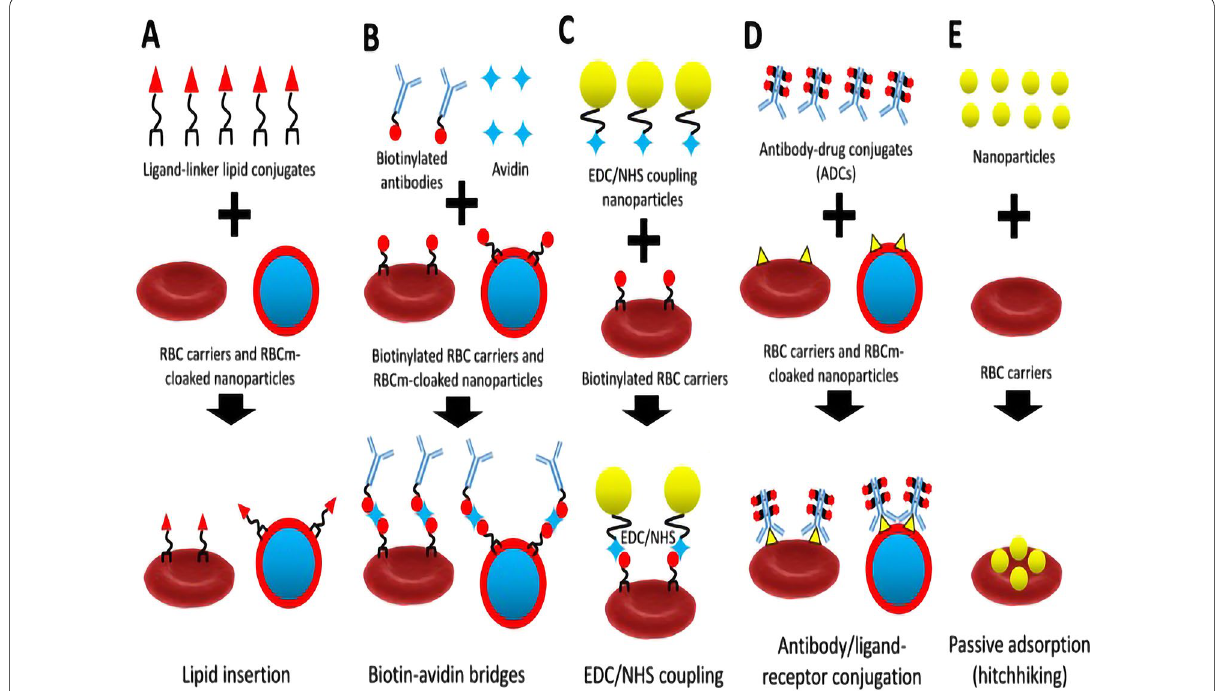
Fig. 1 Schematic diagram of binding method between erythrocyte membrane and NPs ( A ), biotin-avidin bridges ( B ), EDC/NHS coupling ( C ), antibody/ligand-receptor conjugation ( D ), and passive adsorption (hitchhiking) ( E ) methods for refunctionalization of erythrocyte-based nanomedicine. Reprinted with permission from Ref. [30]. Copyright © 2019,